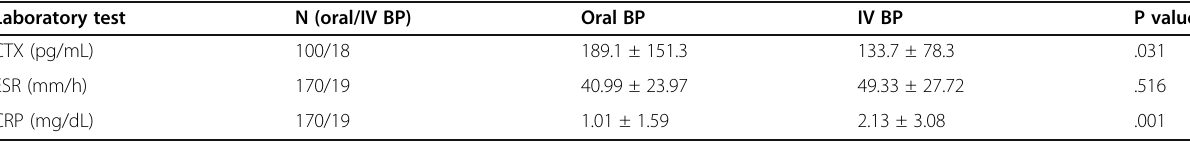
Table 3 Laboratory